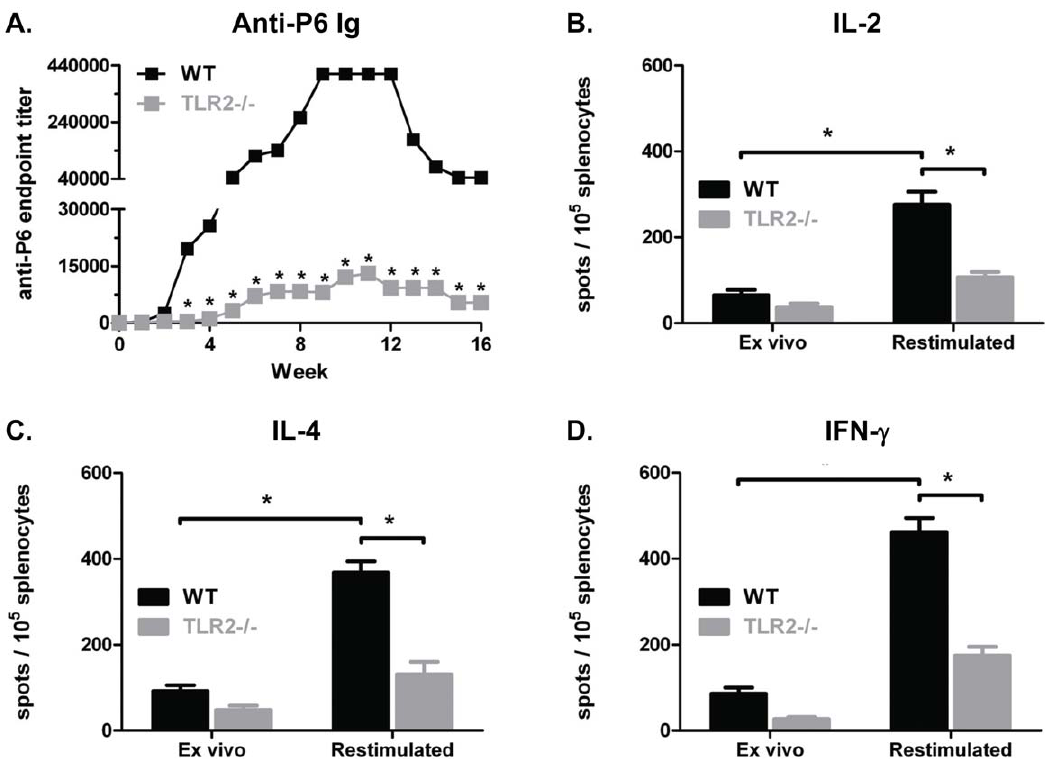
Figure 7. TLR2 expression is important for antibody and recall cytokine responses against P6. WT (black bar) and TLR2 2 / 2 (gray bar) mice were immunized i.p. with 40 m g of native P6 emulsified in CFA, IFA, and PBS. ( A ) Anti-P6 Ig levels were measured in pre-immune and post- immune sera by ELISA. ( B–D ) Frequency of cytokine secreting T cells in spleens from the same animals after 16 weeks were measured by ELISPOT. Splenocytes were assayed directly ex vivo and after 3 day restimulation with BMDCs pulsed with native P6. Plates were developed and spots enumerated microscopically. *p , 0.05 2way ANOVA with Bonferroni post-test comparison of WT and TLR2 2 / 2 .